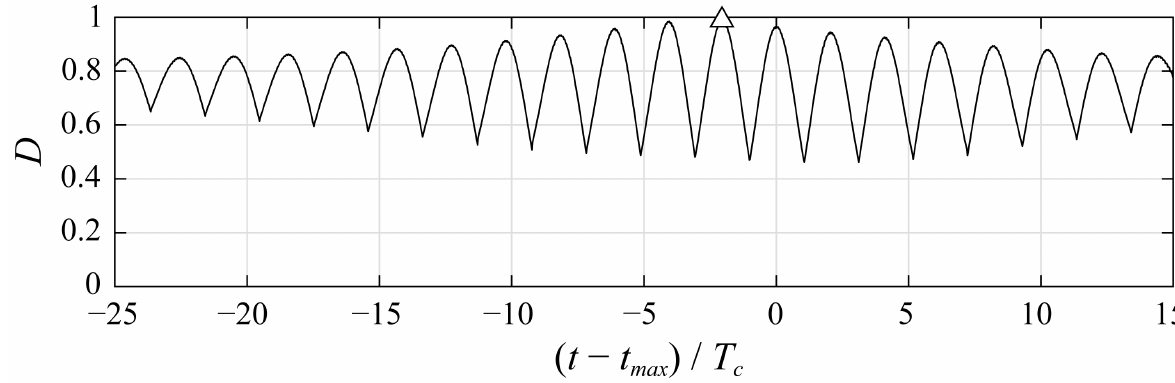
Figure 13. Temporal evolution of the phase convergence D of the modulated wave train with a 0 k c = 0.105 at approximately the time of the maximum crest height ( t = t max ) in the HOSM simulation. The triangle indicates the maximum